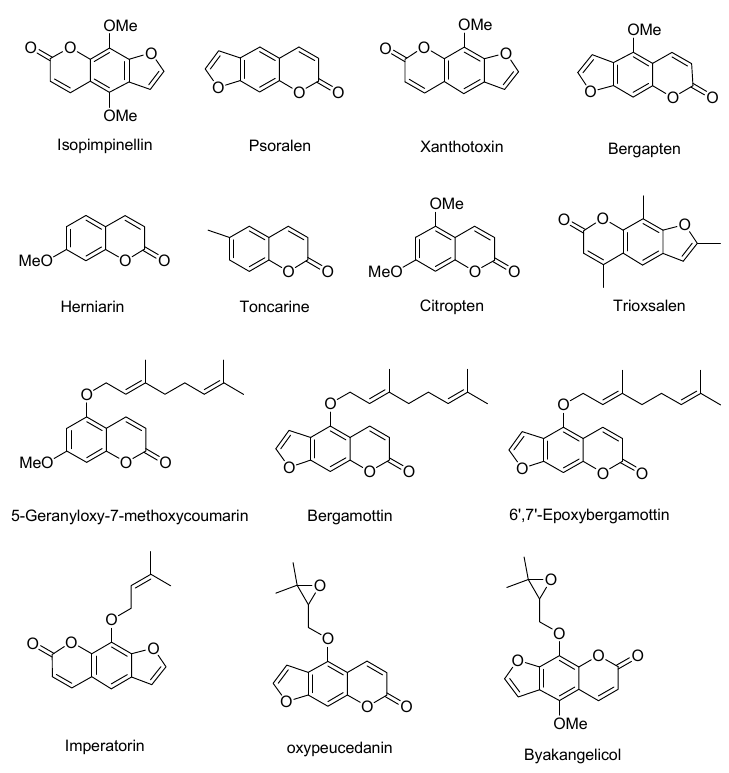
Figure 1. Chemical structure of key non-volatile components in expressed Citrus essential oils.